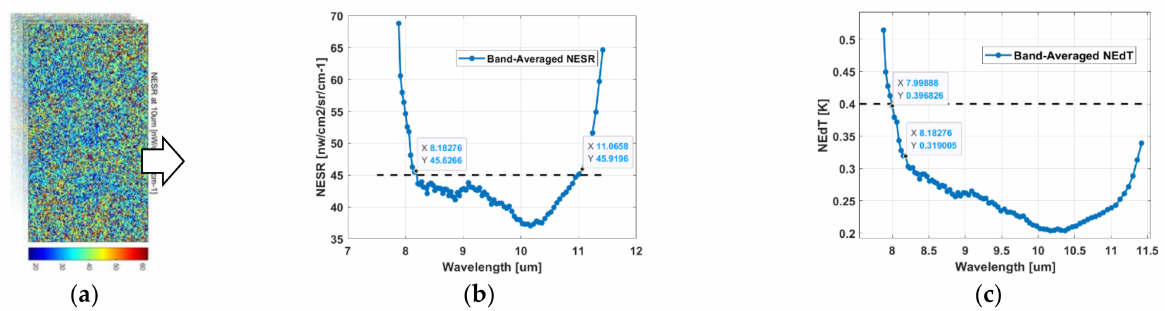
Figure 5. Noise level estimation: ( a ) visualization of the single-band NESR values at 10 µ m; ( b ) the band-averaged NESR; ( c ) the band-averaged